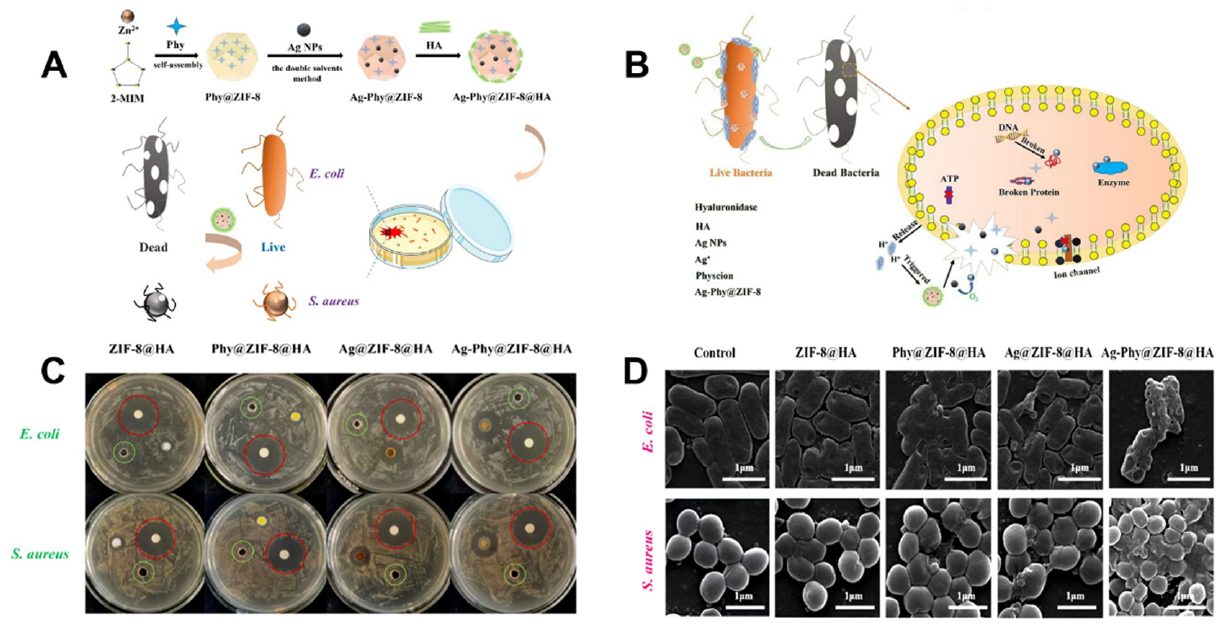
Figure 5. ( A ): Schematic of the Ag-Phy@ZIF-8@HA nanocomposite’s preparation and boosted antibacterial application. ( B ): Possible antibacterial mechanism of the Ag-Phy@ZIF-8@HA. ( C ): Antibac- terial circles of E. coli and S. aureus after they are cocultured with ZIF-8@HA, Ag@ZIF-8@HA, Phy@ZIF-8@HA, and Ag-Phy@ZIF-8@HA for 24 h. Positive control, streptomycin, red circles; Neg- ative control, pH 7.4 PBS, green circles. ( D ): SEM images of E. coli and S. aureus bacteria strains